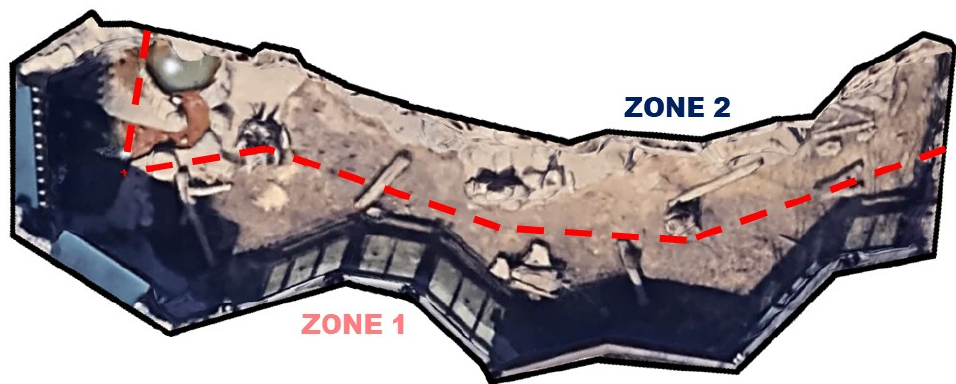
Figure 2. Map of the 539 m 2 grizzly bear habitat with a red line demarcating the study zones. Map of Saint Louis Zoo, Google Earth. Retrieved from earth.google.com/web/ (accessed on 20 April 2020).